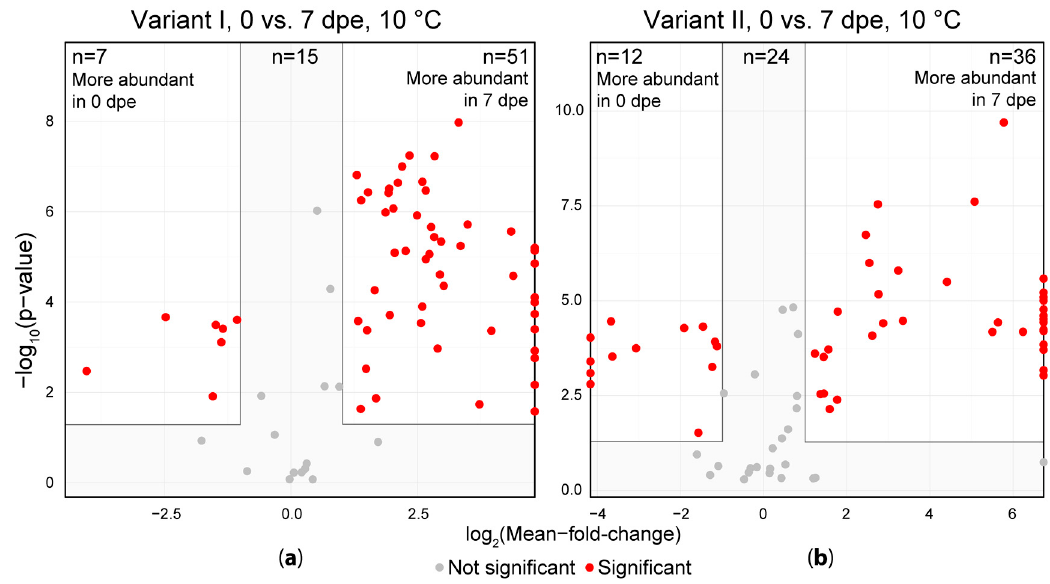
Figure 4. Comparison of sample extracts measured immediately after extraction (0 dpe) and after one week of storage in the auto sample unit (7 dpe). ( a ) shows the acidified extraction solvent (variant I) and ( b ) shows the samples extracted without the addition of formic acid (variant II). Each dot represents one artifact compound. Artifacts depicted on the left or right vertical line (border of the volcano plot) indicate, that the respective artifact was only detected in either one the two groups and thus the respective fold is infinite.